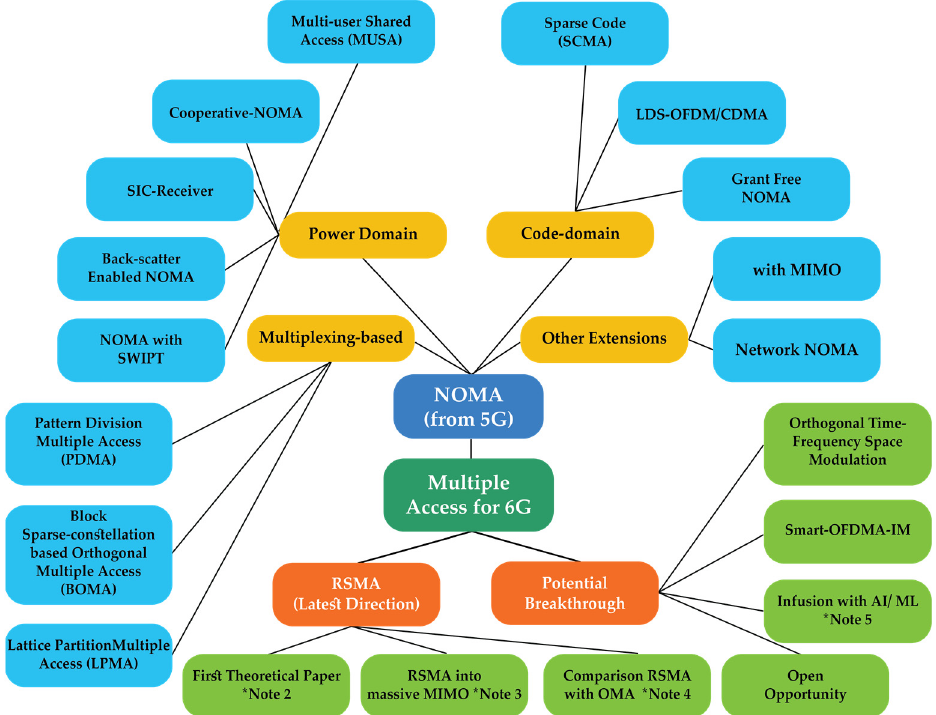
Figure 9. Classification of the potential multiple access techniques for 6G. * Note 2: Ref. [109] , * Note 3: Ref. [110] , * Note 4: Ref. [111] , * Note 5: Ref. [108]